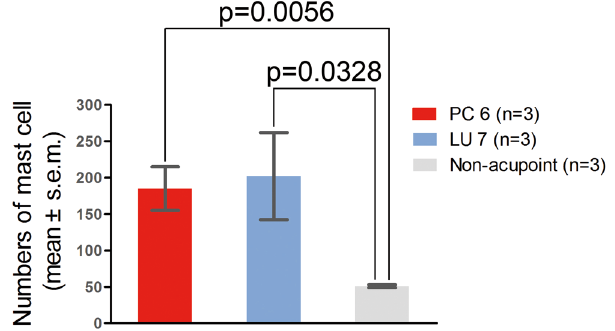
Figure 2. Numbers of mast cells in PC 6, LU 7 and the non-acupoint (n = 3).